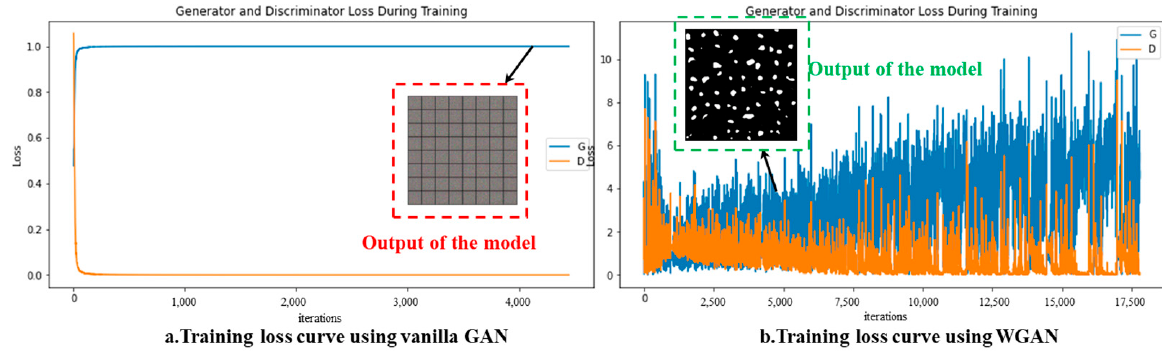
Figure 7. Training loss curve using GAN vs. WGAN. ( a ): The training process of M-DCGAN with original GAN. ( b ): The training process of M-DCGAN with WGAN.